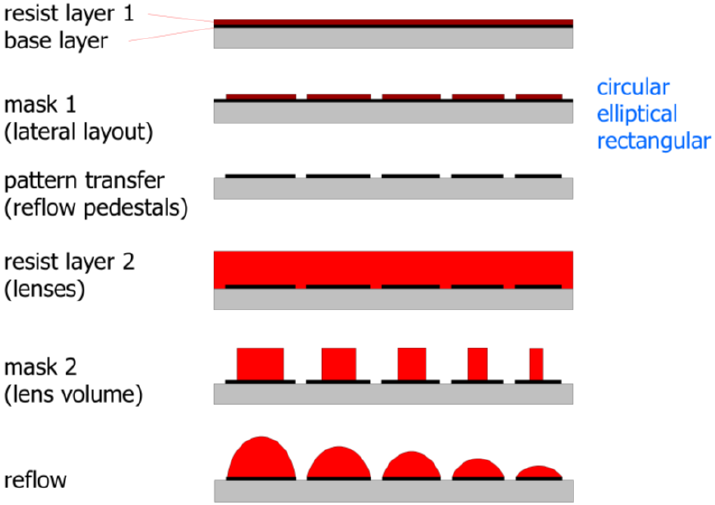
Figure 4. Scheme of a two-mask process to generate chirped lens arrays.